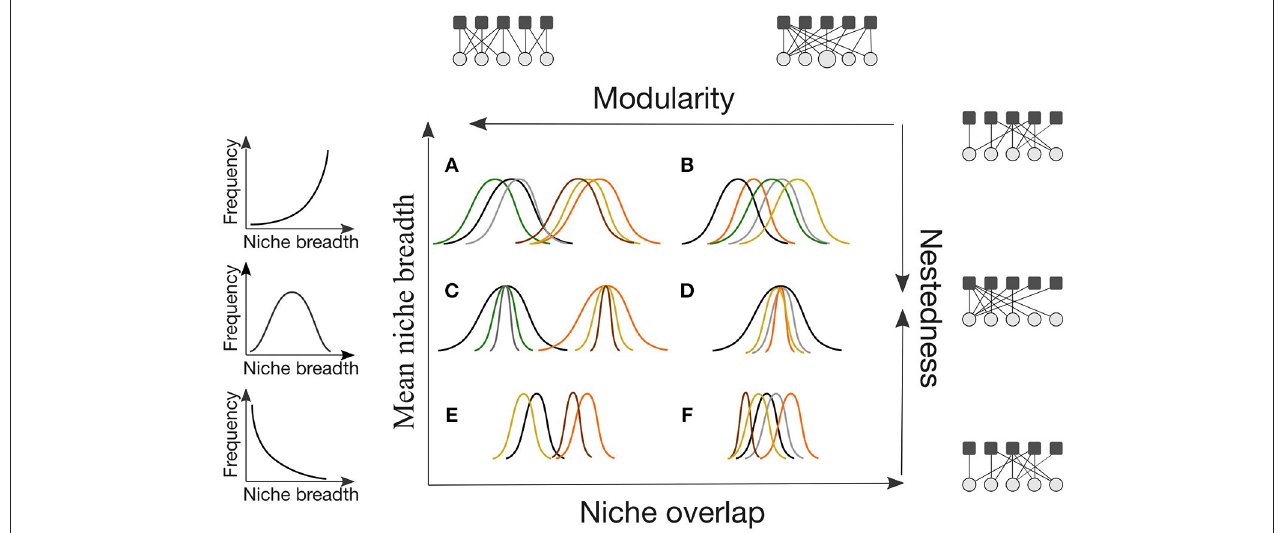
FIGURE 1 | Conceptual figure illustrating the interplay of interaction niche overlap and interaction niche breadth in determining the arrangement of interactions in a community, and specifically nestedness and modularity (A–F) . In the accompanying network figures, white circles represent one trophic level (e.g., pollinators) and dark squares represent the other trophic level (e.g., plants). Each color represents a species. Within our review, we could not find evidence of communities exhibiting a structure as depicted in (F) .